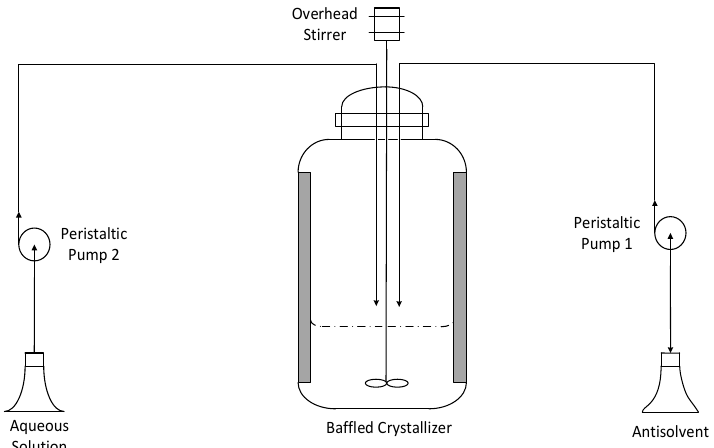
Figure 2. Baffled batch crystallizer with an overhead stirrer held on a stand.